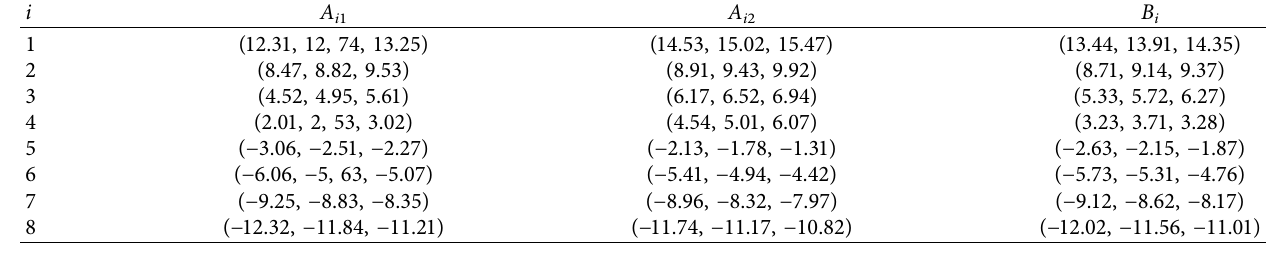
Table 2: The fuzzy sets in the initialized rule